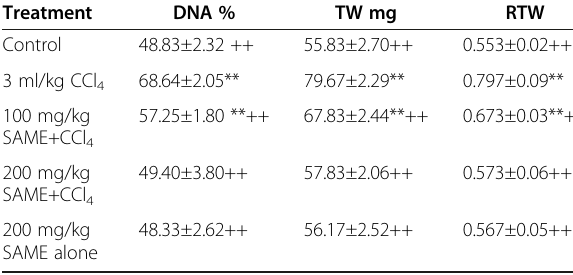
Table 5 Effect of SAME on thyroid % DNA, TW, RTW Treatment